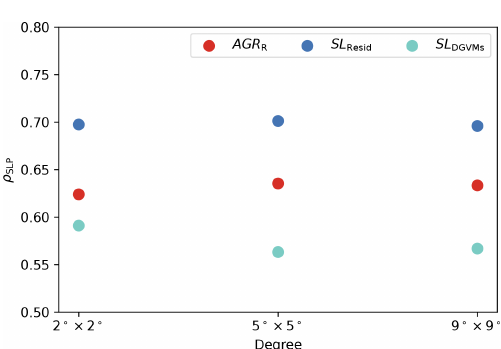
Figure A1. ρ SLP of AGR R , SL Resid , and SL DGVMs under different leave-one-out cross-validation in the period of 1959–2017.